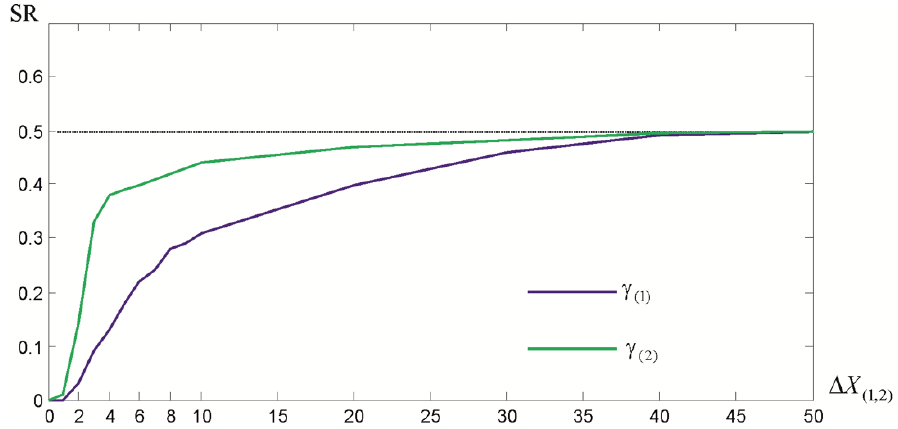
ˆ X ˆ X and (2) for the growing value of ˆ X ˆ X and ( 2 ) for the growing value of